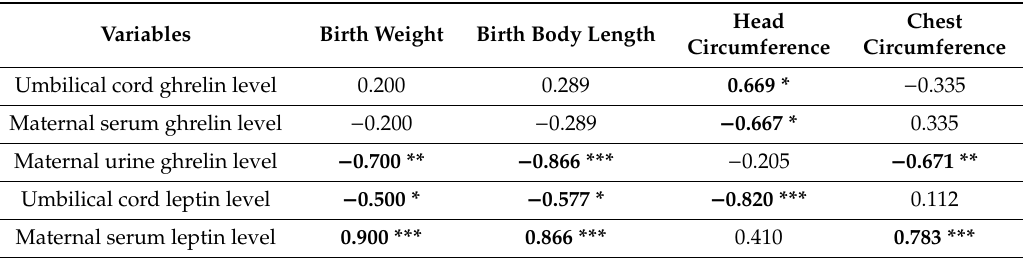
Table 5. Correlations of neonatal anthropometric measurements in the control group in male subjects (Spearman’s rho coe ffi